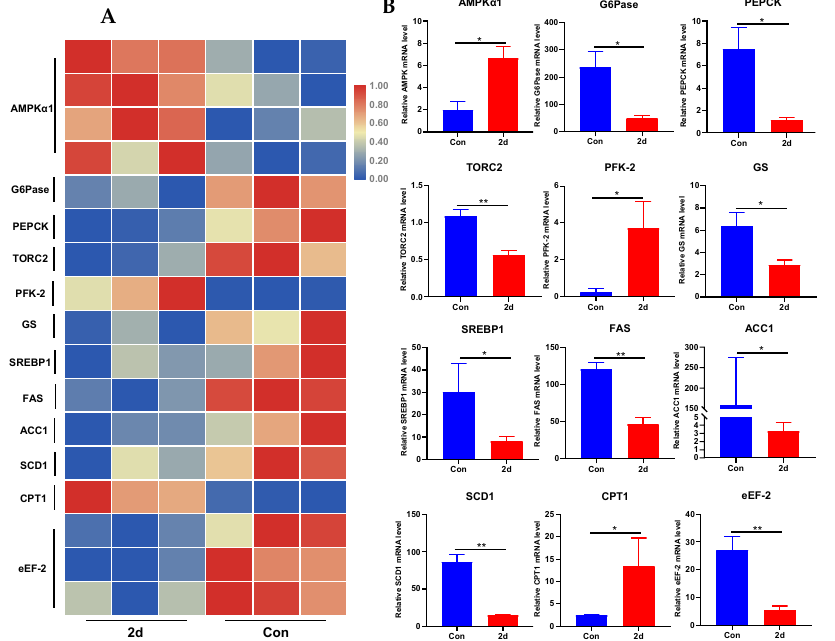
Figure 7. AMPK signaling was dysregulated under hypothermia based on transcriptomic analysis. ( A ) heatmap; ( B ) transcriptional expression of key genes in AMPK signaling pathway retrieved from the transcriptome. Data were analyzed by Student’s t -test with SPSS 23.0, asterisk represents the statistical difference (*, p < 0.05; **, p < 0.01). Results were expressed as mean ± SEM, n = 3.